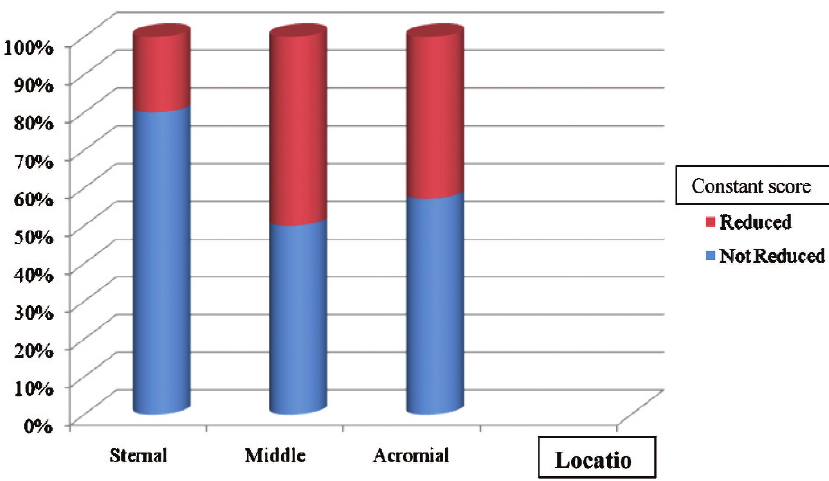
Figure 1 - Clavicle fracture location and